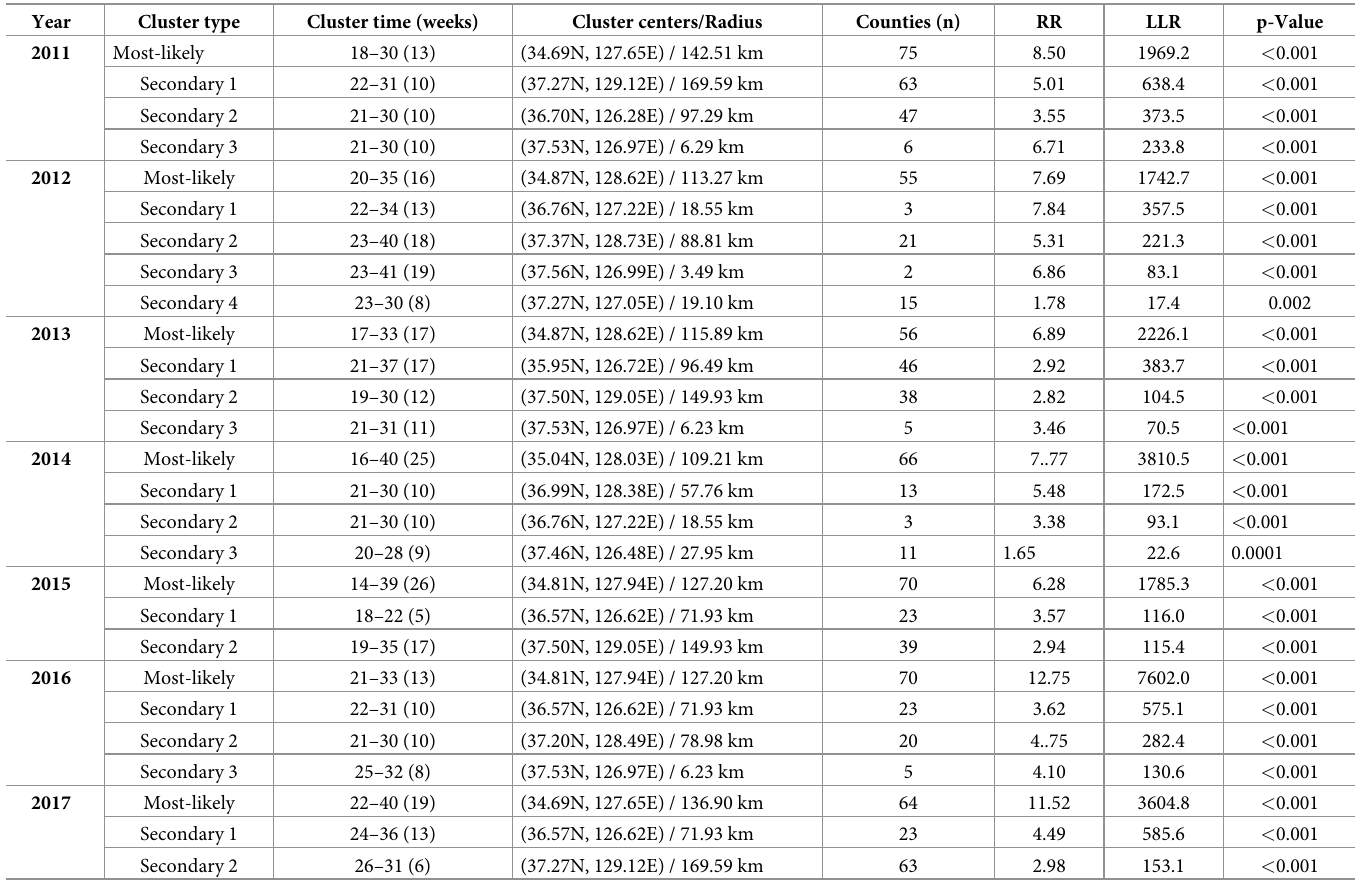
Table 4. Results of the space-time cluster at the district level (inpatients),